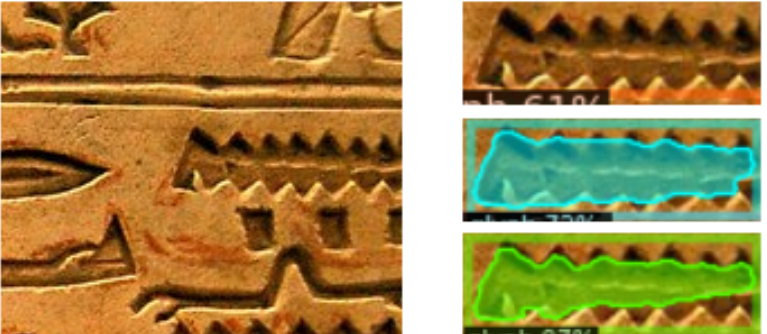
Figure 5. Focus on the segmentation of a single glyph (left) after training for 300, 500, 3000 epochs (right panel, from top to bottom).